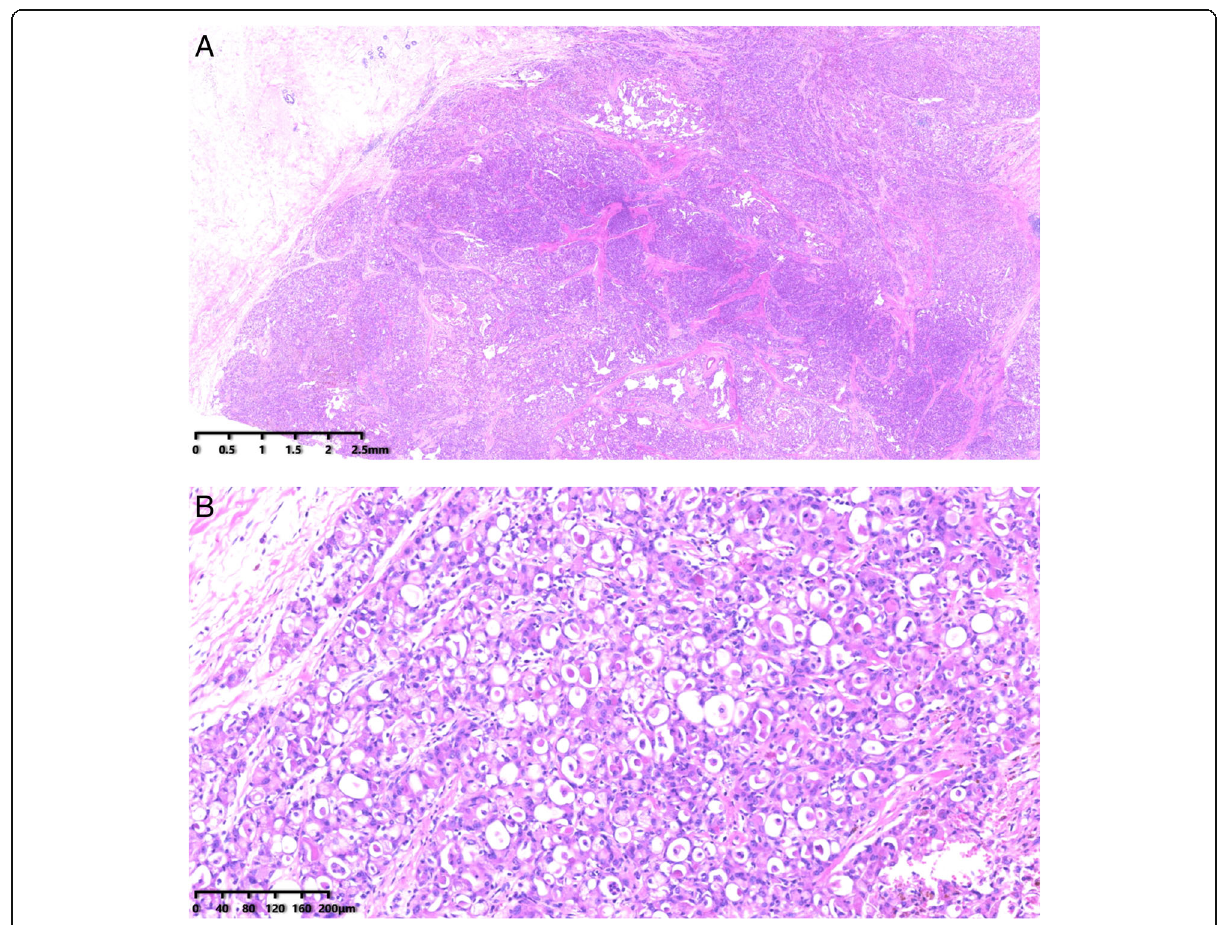
Fig. 2 A The primary tumor in breast. HE 10×. B The primary tumor in breast. HE